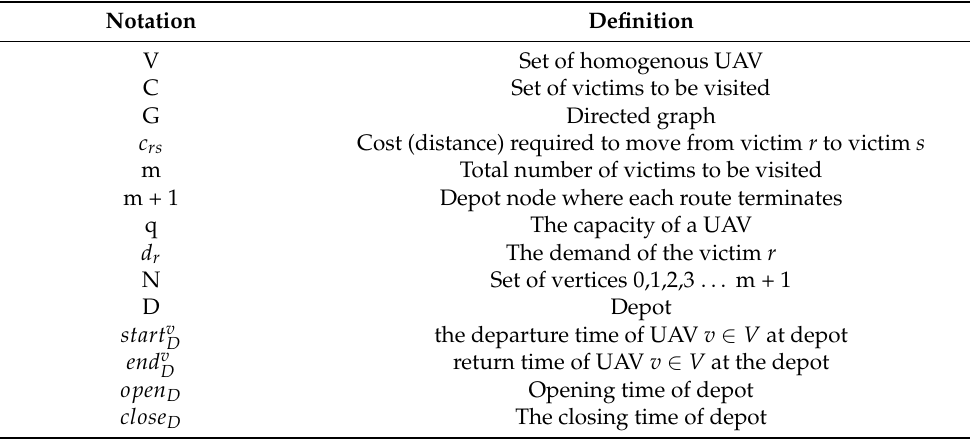
Table 4. Definitions of the mathematical